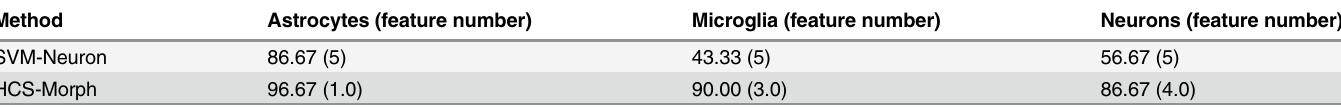
Table 5. Jackknife tests (%) and the mean feature numbers of the SVM-based predictors for 30 samples. Method